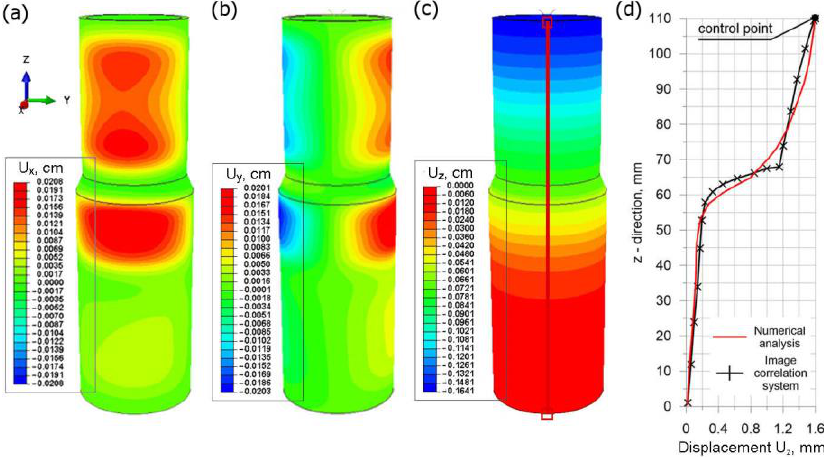
Figure 23. Displacement fields in the compressed sample: ( a ) U x , ( b ) U y , ( c ) U z and ( d ) comparison of U z displacement with experimental test.